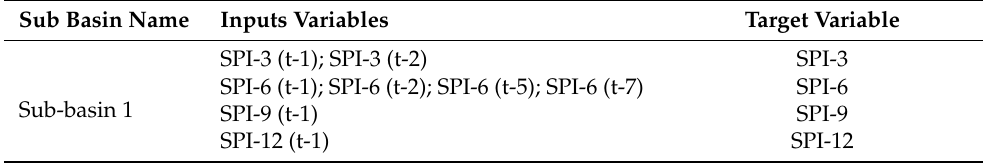
Table 4. Input − output relationships for SPI prediction.